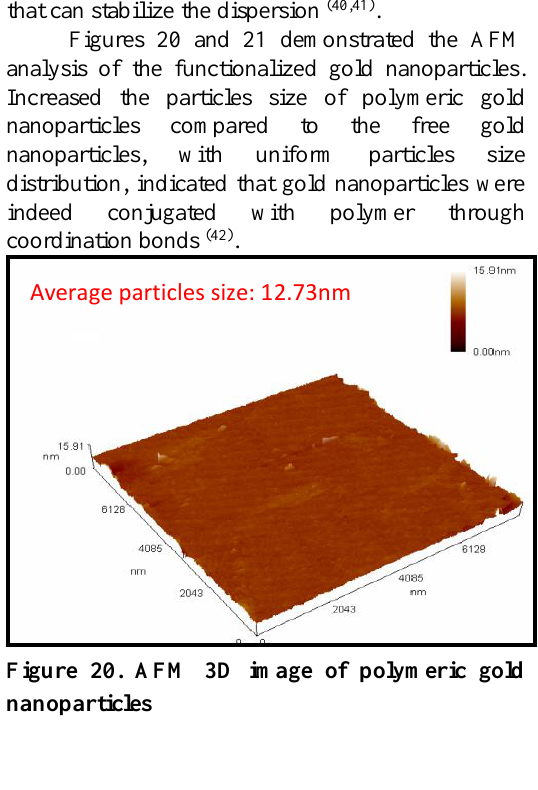
Figure 17. EDX analysis of the optimized gold nanoparticles G21